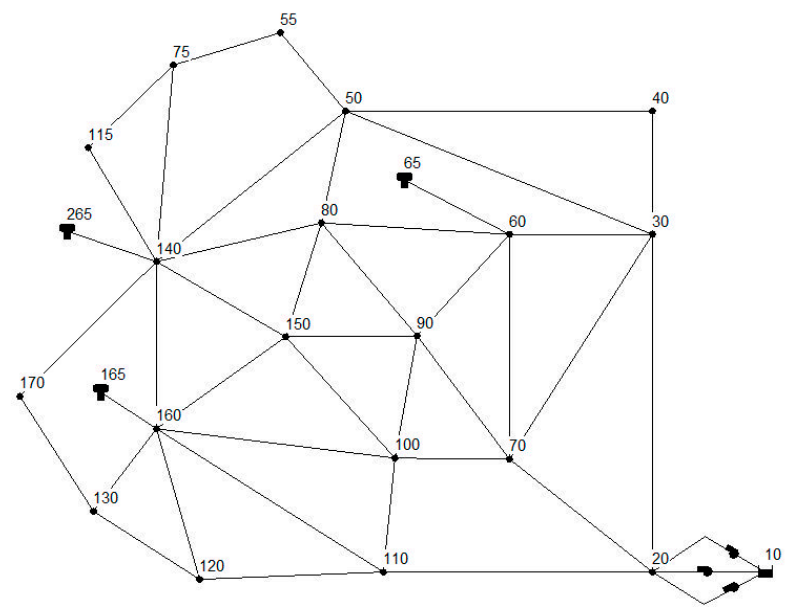
Figure 4. Case 2—Anytown Modified Network.